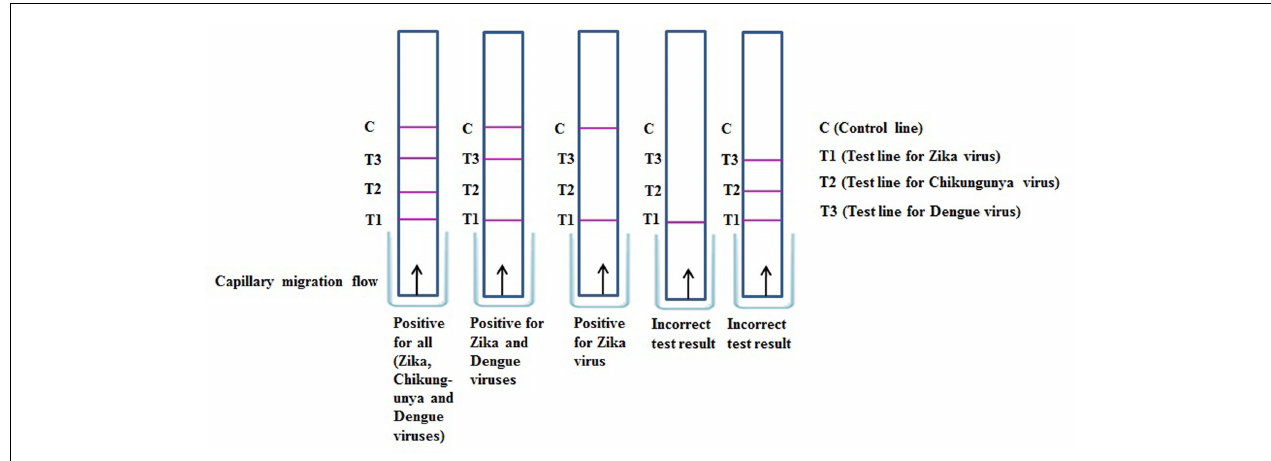
FIGURE 6 | Result interpretation of immunochromatographic strip assay for simultaneous detection of Zika, Chikungunya, and Dengue